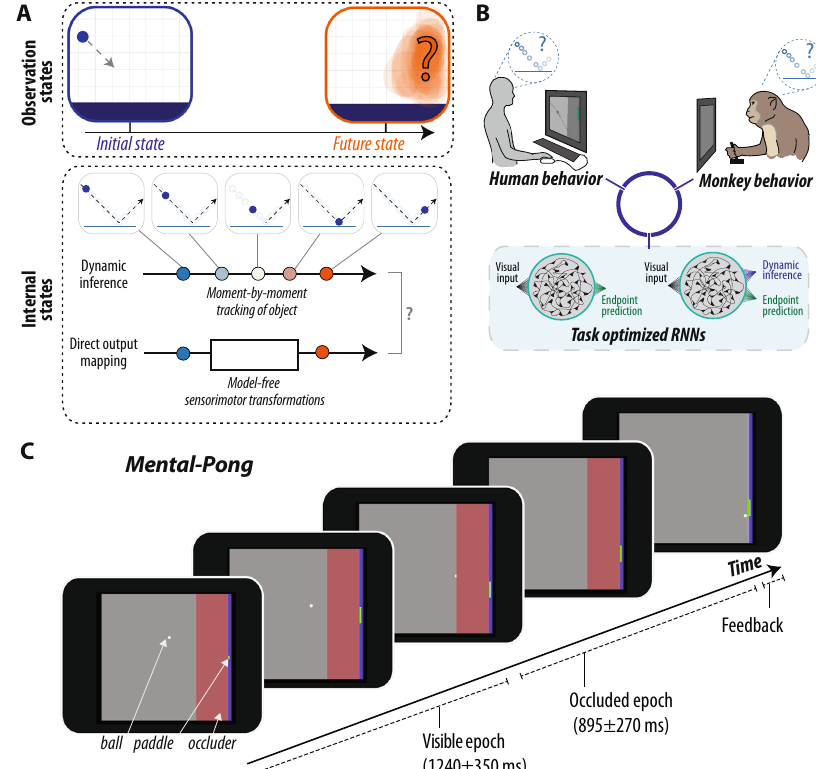
Fig. 1 | Hypotheses and experimental strategy. A Physical predictions. A domi- nant theory in cognitive science is that humans make inferences about physical processes using “ mental simulations ” of the physical world. To illustrate this, the top panel depicts observations of the external world, a ball falling towards the ground.Inmakinganinferenceaboutthefuturestateofthisworld,thebraincould formadynamicinferenceengine,i.e.,dynamicallytracklatentenvironmentalstates to generate behavioral outputs. Alternatively, the brain could support such infer- ences via automatized nonlinear function approximations, without explicitly trackinglatentenvironmentalstates. B Experimentalstrategy.Wetestedthemental simulation hypothesis by directly comparing the behavior of humans,